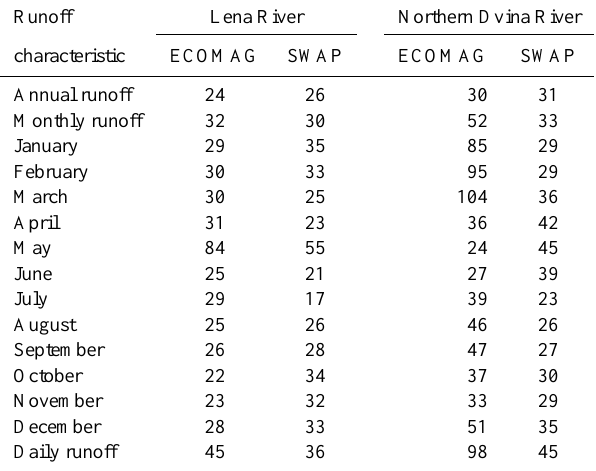
Table 3. Uncertainty indices UN(SD) (in %) for SD estimates of the annual and monthly